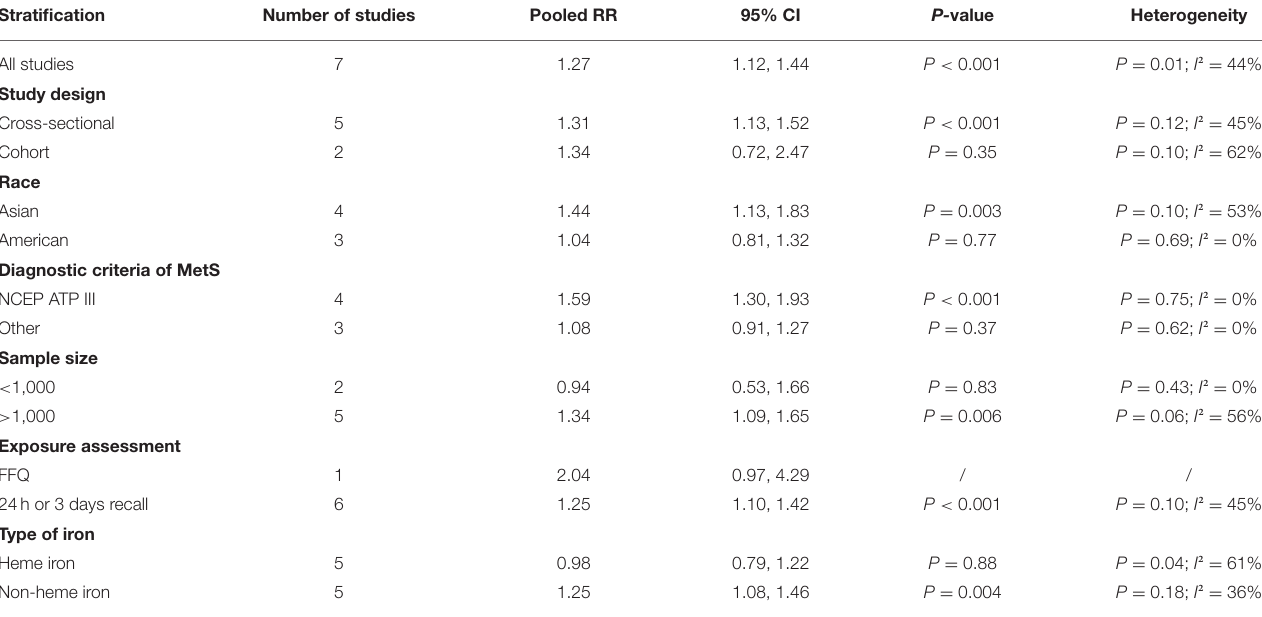
TABLE 2 | Subgroup analysis of metabolic syndrome (MetS) for the highest vs. lowest dietary iron level